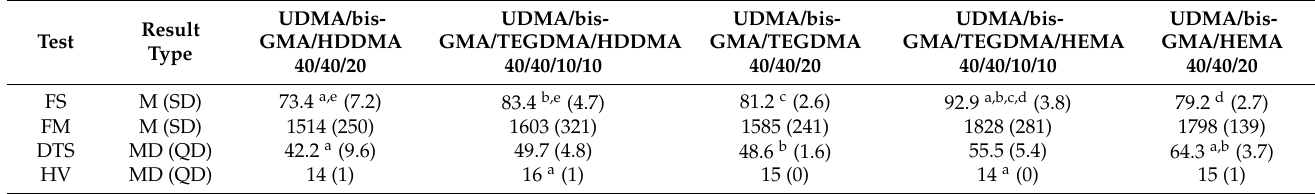
Table 2. The results of flexural strength (FS), flexural modulus (FM), diametral tensile strength (DTS) and hardness (HV) for resin materials. Values are given as mean with standard deviation (SD) or median with quartile deviation (QT), based on distribution and homogeneity of variance. The results with the same assigned letter show a statistical difference at the level of p ≤ 0.05. The results without the assigned letter do not show a statistical